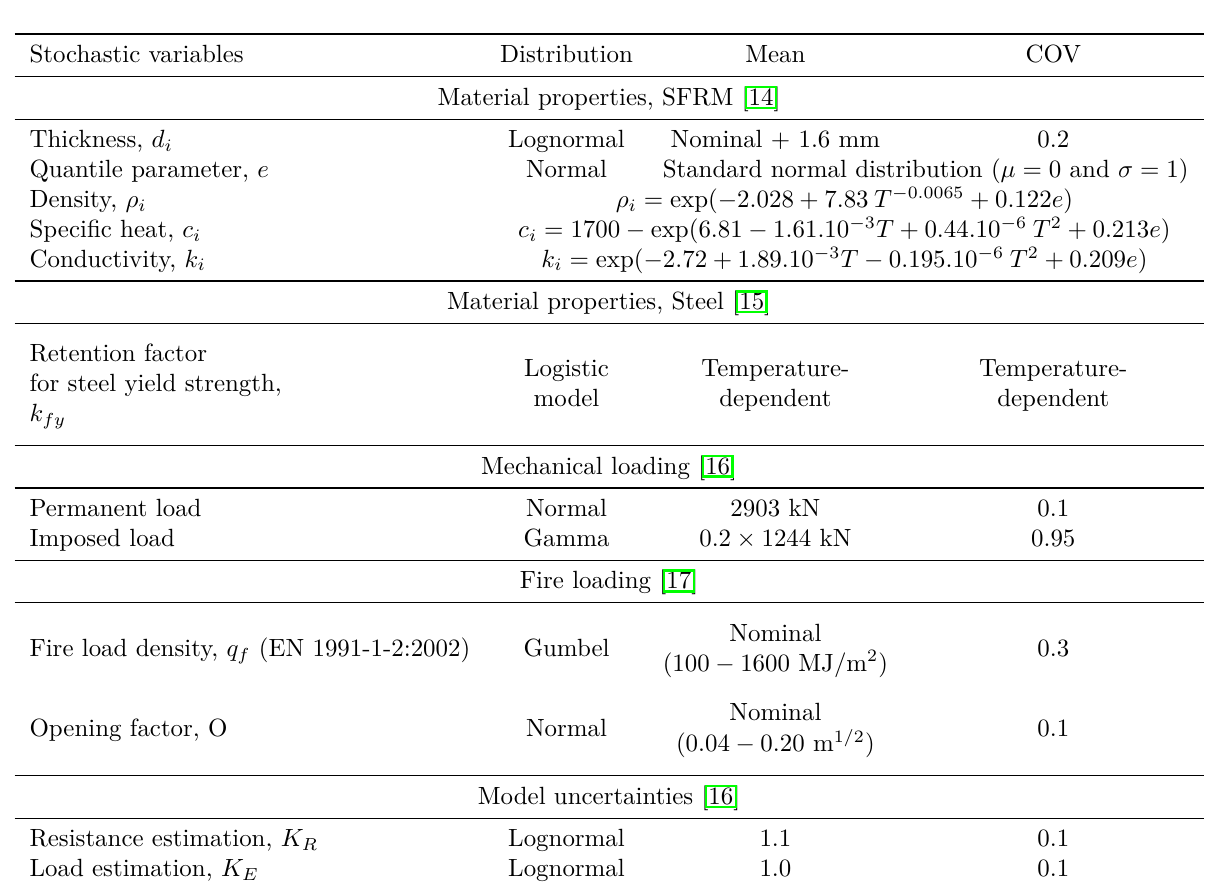
Table 1. Stochastic parameters for the probabilistic analysis of steel